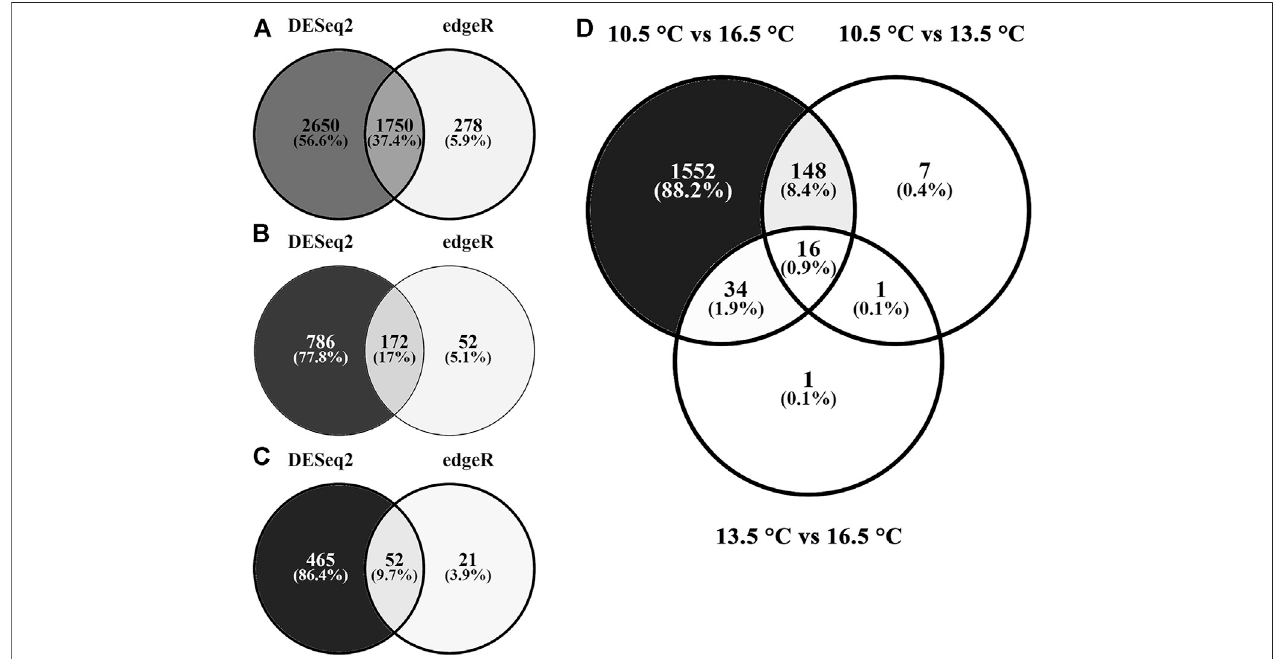
FIGURE1| Differentialtranscriptexpression inresponse torearing temperature.Venndiagrams depictthenumber ofshared andseparatedifferentially expressed (both up- and down-regulated; FDR-adjusted p < 0.05) transcripts identi fi ed by either DESeq2 (left), edgeR (right), or those in common (middle). Temperature comparisons are presented as (A) 10.5 ° C vs. 16.5 ° C, (B) 10.5 ° C vs. 13.5 ° C, (C) 13.5 ° C vs. 16.5 ° C, and (D) differentially expressed transcripts shared between both DESeq2 and edgeR for each pairwise